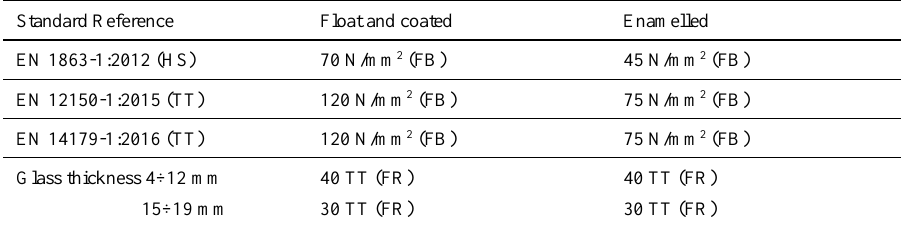
Table 2: Minimum value of Bending Strength and number of fragments